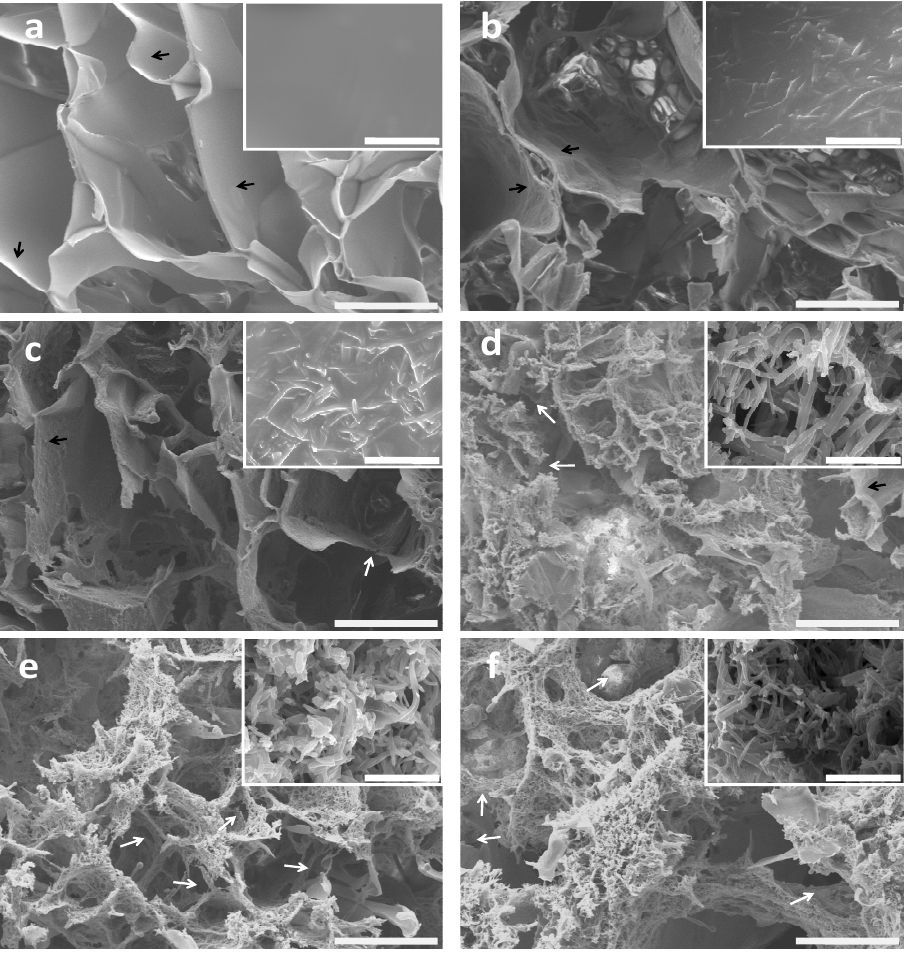
Figure 2. SEM images of BSF scaffolds with different proportions of ASF micro/nano fibers added: ( a ) 0; ( b ) 50%; ( c ) 100%; ( d ) 150%; ( e ) 200%; ( f ) 250%. The insert images show high magnification of the porous walls of the scaffolds. The lamellar pore walls and connected channels are indicated by black and white arrows, respectively. Scale bars: ( a , b , c , d , e , f ) 100 μ m; inset images 10 μ m.